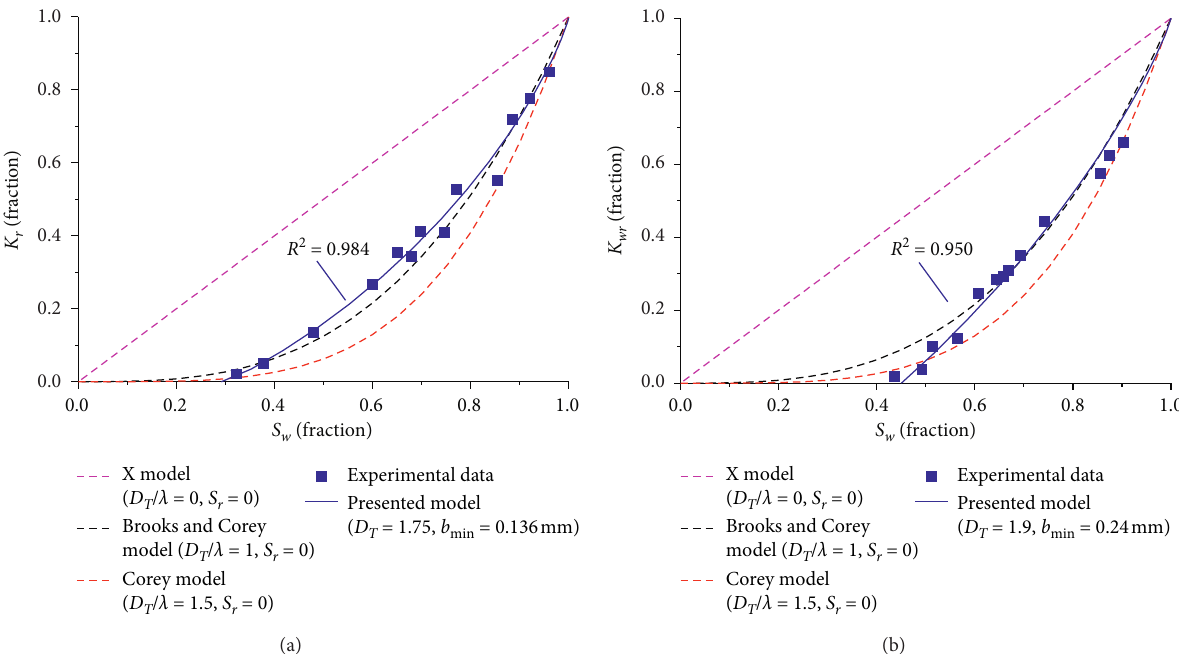
Figure 5: Comparisons of relative permeabilities between the present model and measured data: (a) homogeneously rough with u � 0.145mm and δ � 0.03mm and (b) randomly rough with u � 0.24 mm and δ �